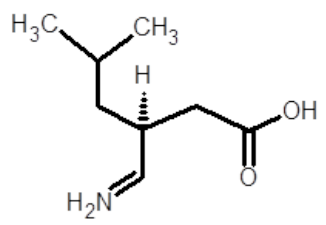
FIGURE 1 - Structure of pregabalin.